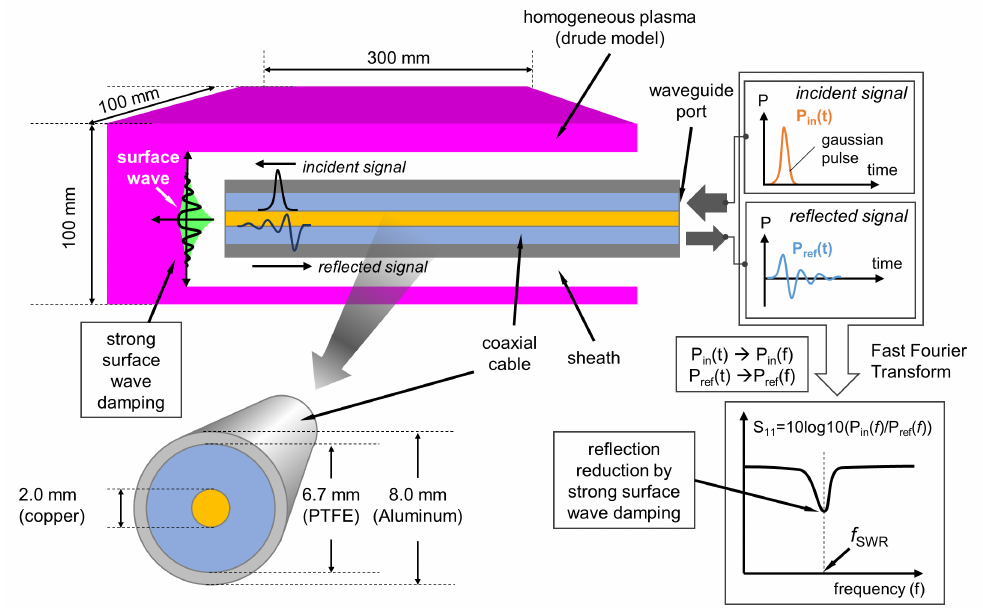
Figure 1. Schematic diagram for the simulation